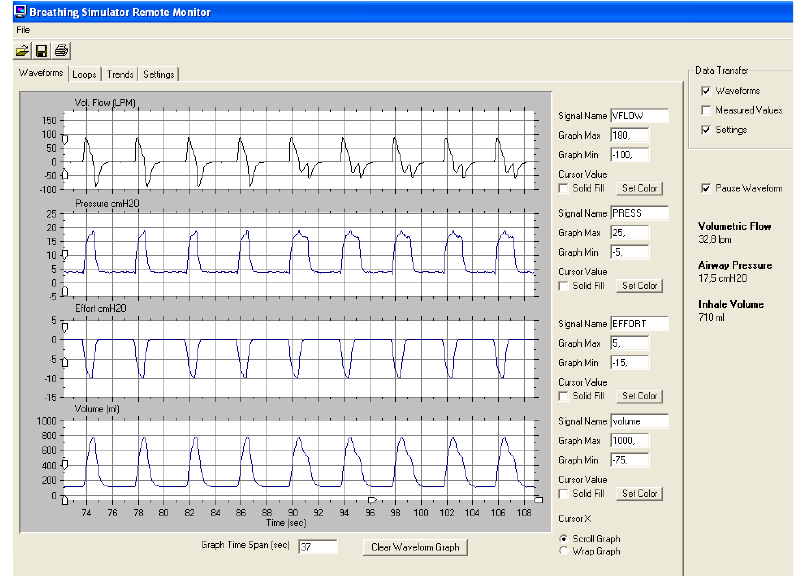
Figure 3. Bench experiment evaluating minimum inspiratory time. In the first half of the tracing, Ti min was not set, whereas in the second half was set at 1.3 s, without gaining any volume (fourth channel). Parameters: IPAP 18/EPAP 5, cycling criterion